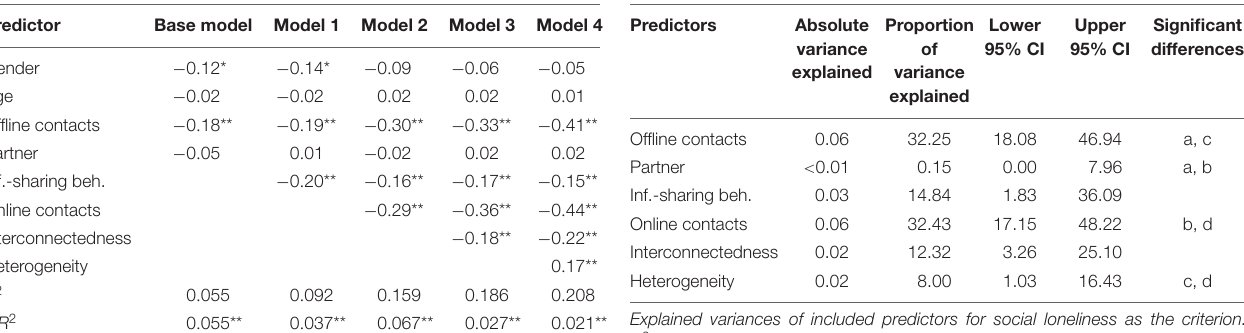
TABLE 4 | Relative importance analysis results.